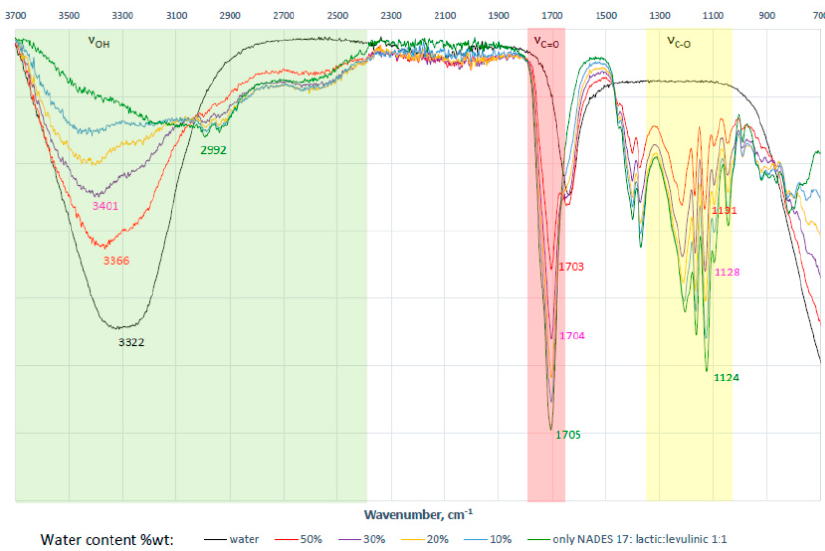
Figure 3. Changes in the supramolecular structure of NADES-17 induced by water content (based on FT-IR spectra).